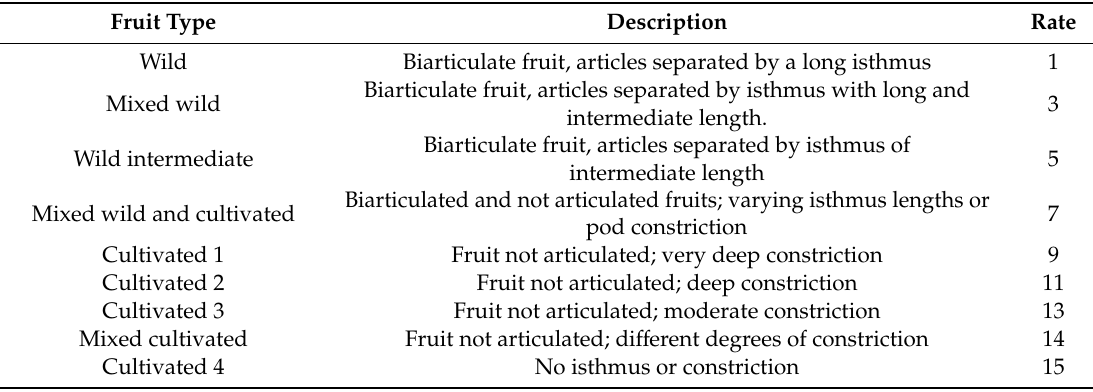
Figure 1. Variation for fruit type in an interspecific peanut population. Table 1. Grade scale for fruit type for peanut interspecific populations.